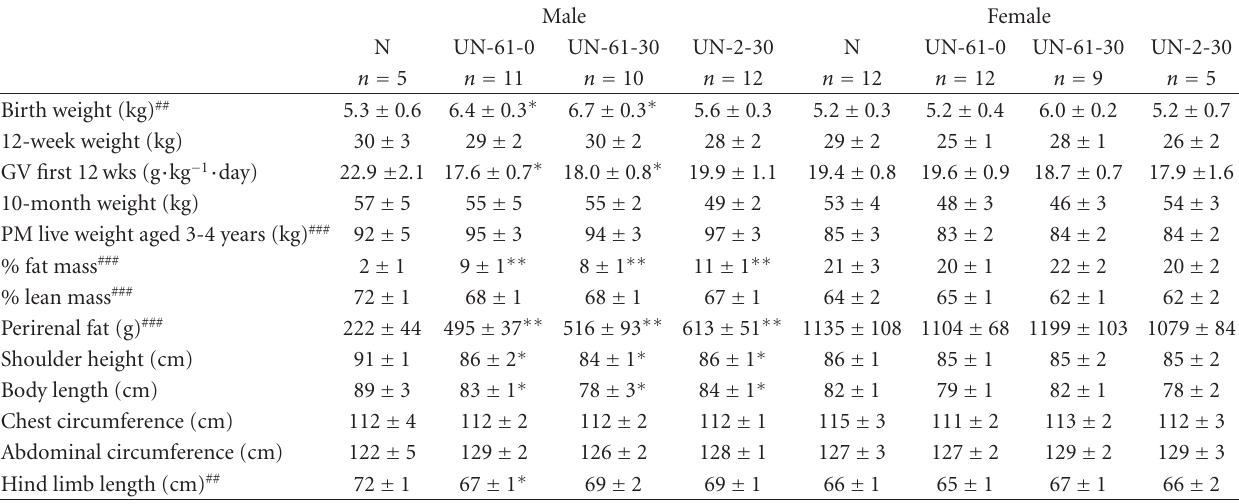
Table 1: Weight, body composition, and skeletal growth measurements in male and female o ff spring of ewes undernourished before (UN- 61-0), before and after (UN-61-30), or after (UN-2-30) mating (day 0) compared with o ff spring of normally fed ewes